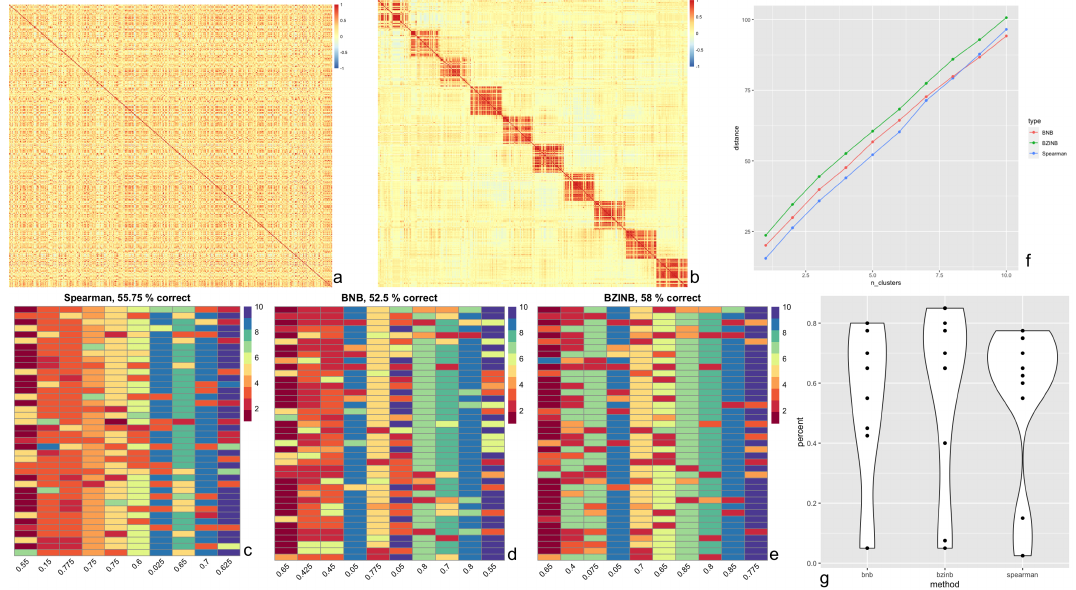
Figure 3. Results of BZINB-based spectral clustering of species. ( a ) Heatmap of BZINB-based correlation between Kraken2/Bracken counts of 400 of the species in ZOE 2.0 in a random order; ( b ) Heatmap of BZINB-based correlation of the Kraken2/Bracken count data (in the same order as in ( a )) after introducing simulated clusters; ( c – e ) Each column of cells represents a true cluster based on simulation ( b ), each cell represents one species, and the color is the indicator of the predicted cluster using the affinity matrix made from ( c ) BNB, ( d ) BZINB, and ( e ) Spearman correlations. There are 10 distinct colors used to represent the 10 clusters; ( f ) Distance (Frobenius norm) between the correlation matrices of nested predicted clusters between data with (as in Figure 3b) and without (as in Figure 3a) increased correlations that represented the clusters: the first set (number of clusters = 1) is the predicted cluster with the greatest distance between correlation matrices. For each increase in the number of clusters, we included an additional cluster in the order of decreasing distances. This was done using the BNB-based, BZINB-based, and Spearman correlation matrices and their corresponding cluster predictions; ( g ) Violin plot of cluster-wise percent accuracy for each of the 10 clusters comparing BNB, BZINB, and Spearman correlation-based affinity